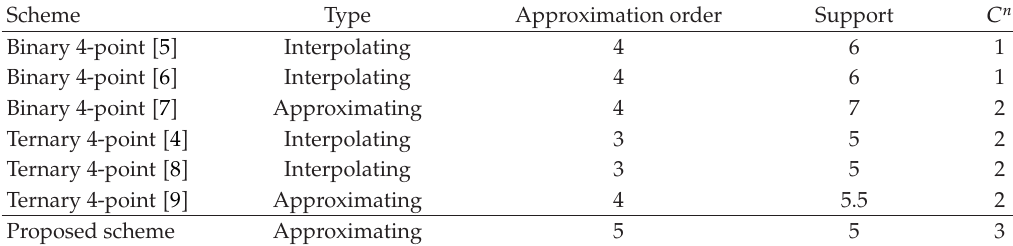
Table 1: Comparison of proposed 4-point scheme with other 4-point